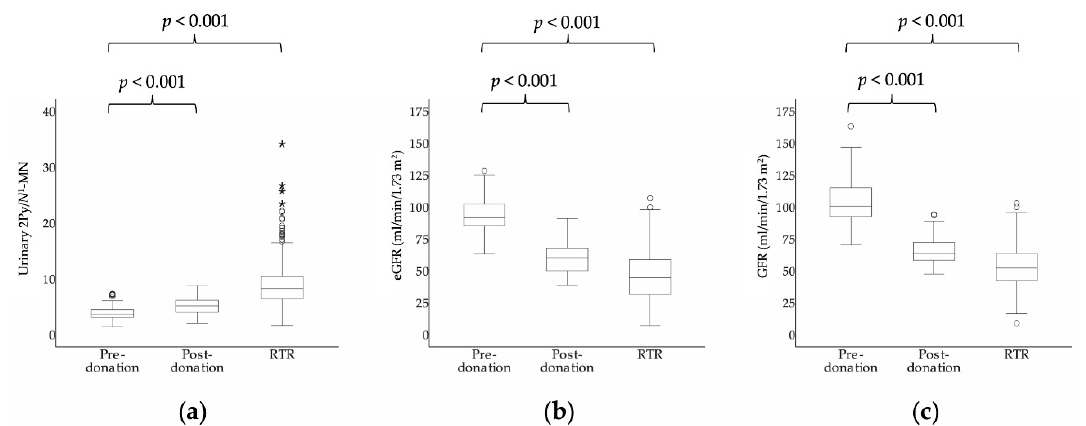
Figure 2. Box plots of ( a ) urinary 2Py / N 1 -MN, ( b ) eGFR and ( c ) GFR in kidney donors before ( n = 85) and after kidney donation ( n = 85) and RTR ( n = 660), respectively. Boxes, bars and whiskers represent IQRs, medians and values < 1.5 × IQR, respectively, whereas outliers (1.5–3 × IQR) are indicated by circles and extreme outliers ( > 3 × IQR) by asterisks. p -value for di ff erence between kidney donors before and after kidney donation was tested by paired samples t and Wilcoxon signed rank tests for normally and skewed distributed continuous variables, respectively. p -value for di ff erence between RTR and kidney donors before donation was tested by t and Mann–Whitney tests for normally and skewed distributed continuous variables, respectively. eGFR, estimated glomerular filtration rate; GFR, glomerular filtration rate; N 1 -MN, N 1 -methylnicotinamide; RTR, renal transplant recipients; 2Py, N 1 -methyl-2-pyridone-5-carboxamide; 2Py / N 1 -MN, ratio of 2Py to N 1 -MN. Table 2. Associations of urinary 2Py / N 1 -MN with kidney function in RTR and kidney donors before and after kidney donation 1